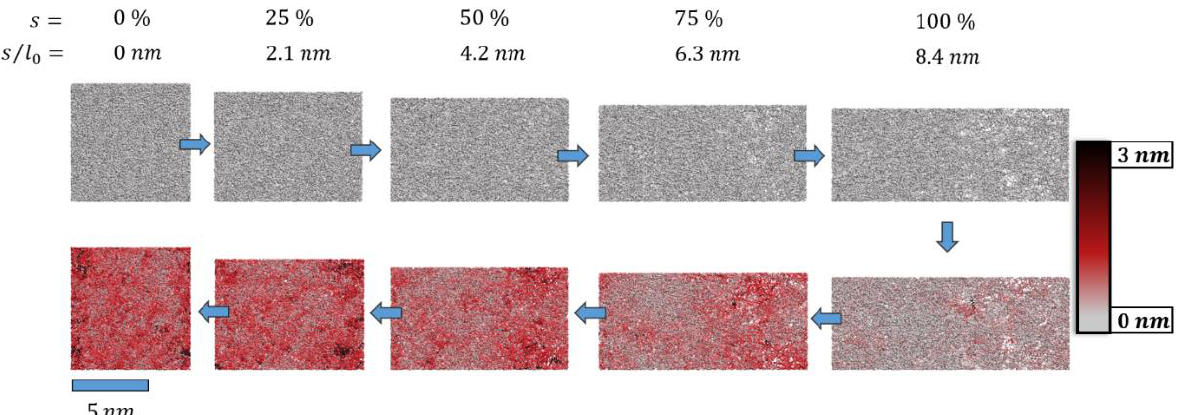
Figure 4. Snapshots of the pristine epoxy model (top left, l 0 = 8.4 nm) before and after deformation by s = f ∙ l 0 (upper panel, 𝑠̇ = 0.84 m∙s − 1 ). After tensile deformation to s max = 8.4 nm, the system was compressed (lower panel, 𝑠̇ = − 0 .84 m∙s − 1 ) back to s = 0 (lower left). For ideal elastic deformation, the